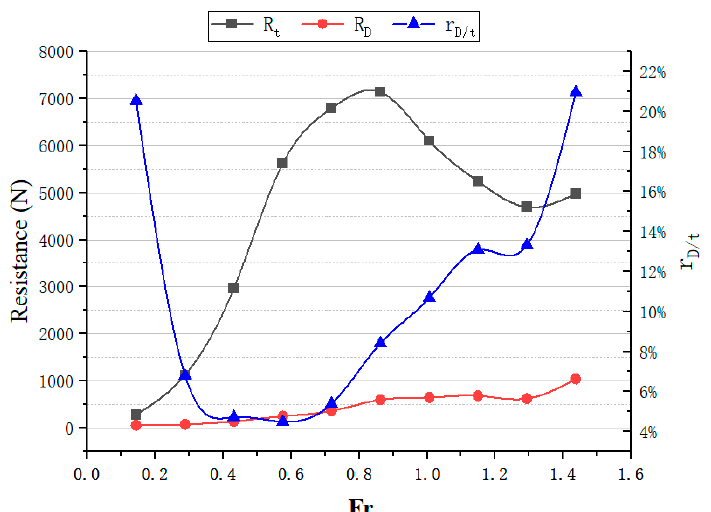
Figure 12. Flanks resistance, total resistance, and ratio r D / t